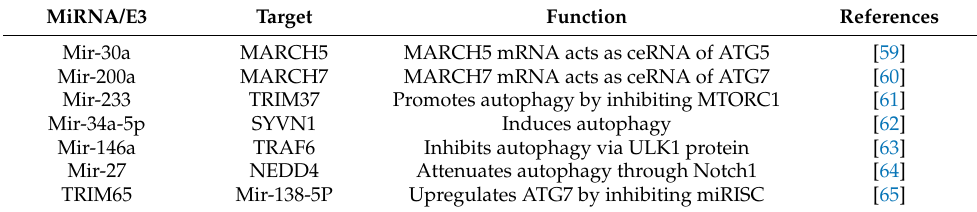
Table 1. MiRNAs and E3 ligases involved in autophagy. MiRNA/E3 Target